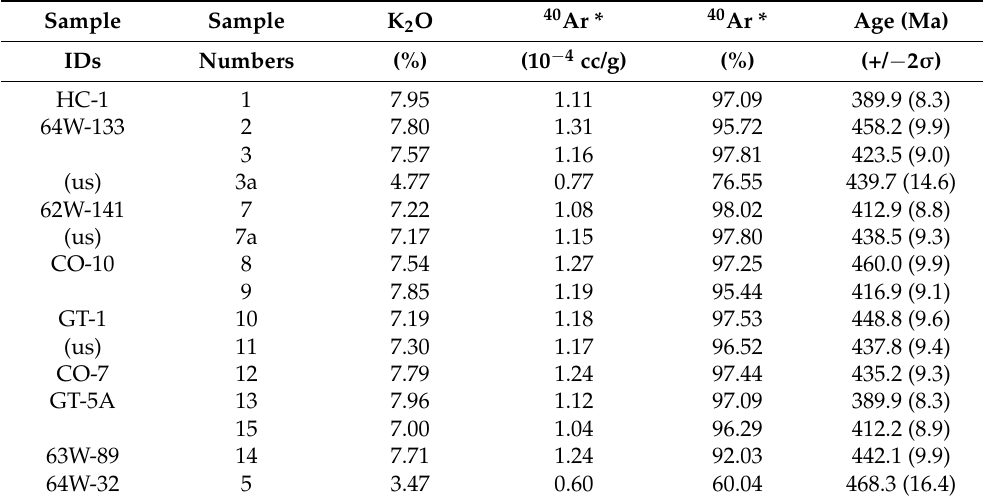
IDs stands for identities and (*) for radiogenic.